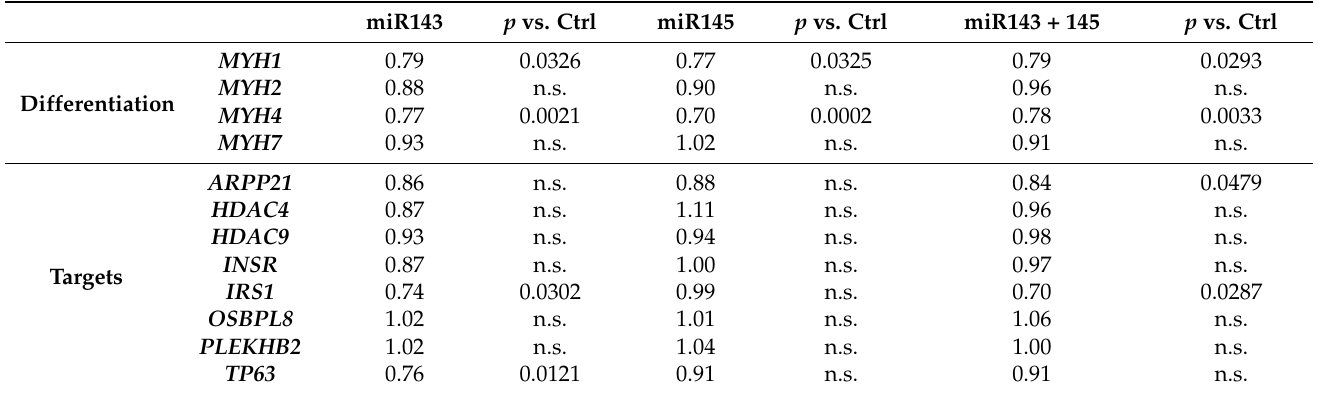
Differentiation